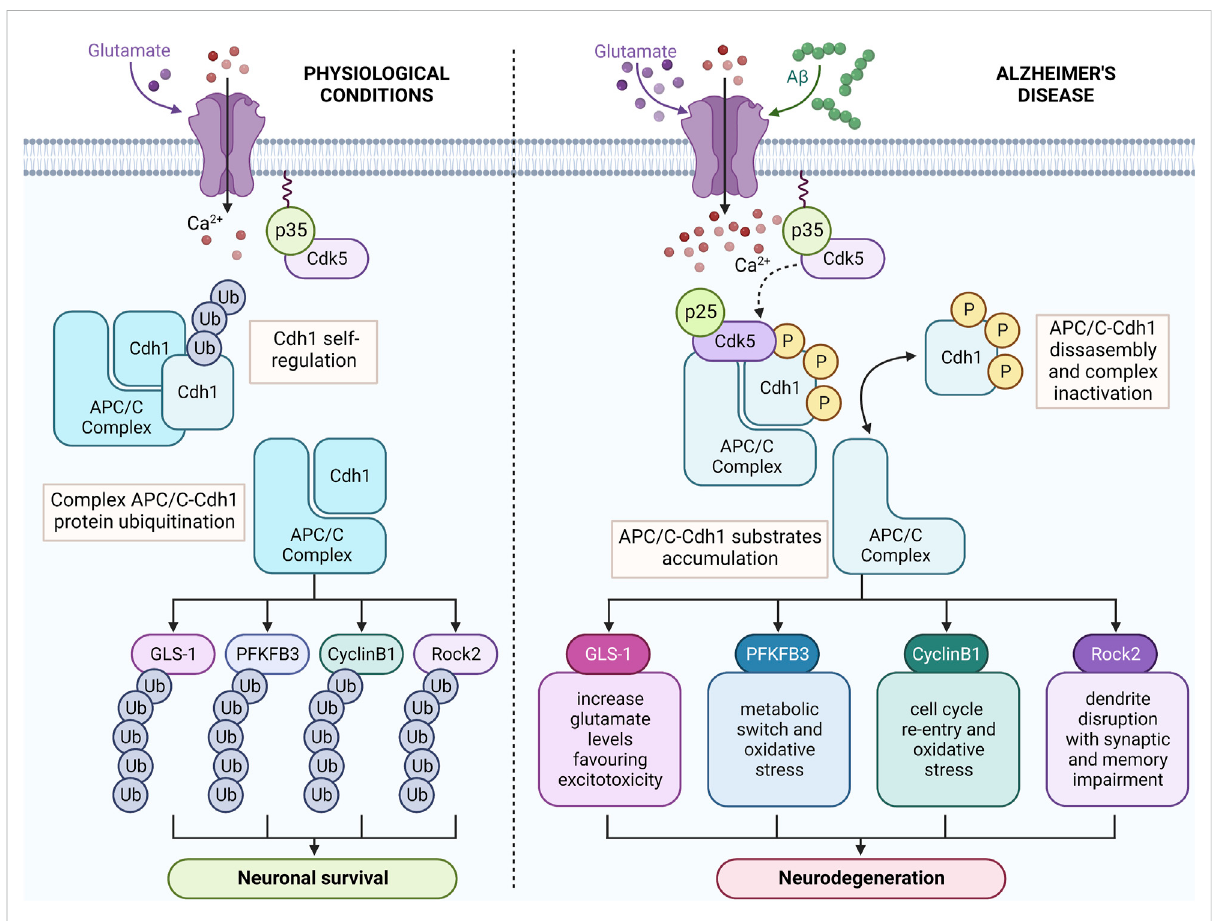
FIGURE 2 Amylod- β (A β ) triggers APC/C-Cdh1 inactivation leading to the accumulation of its neurotoxic targets. Under physiological conditions, APC/C-Cdh1 constantly degrades the metabolic enzymes glutaminase 1 (GLS1) and 6-phosphofructo-2-kinase/fructose-2, 6- bisphosphatase-3 (Pfkfb3), the mitotic cyclin B, and the dendrite destabilizer Rho protein kinase 2 (Rock2) in neurons. In AD pathology, A β induces Cdk5-p25 hyperactivation that phosphorylates Cdh1 resulting in APC/C-Cdh1 inactivation and the accumulation of its targets, leading to neurodegeneration. Created with